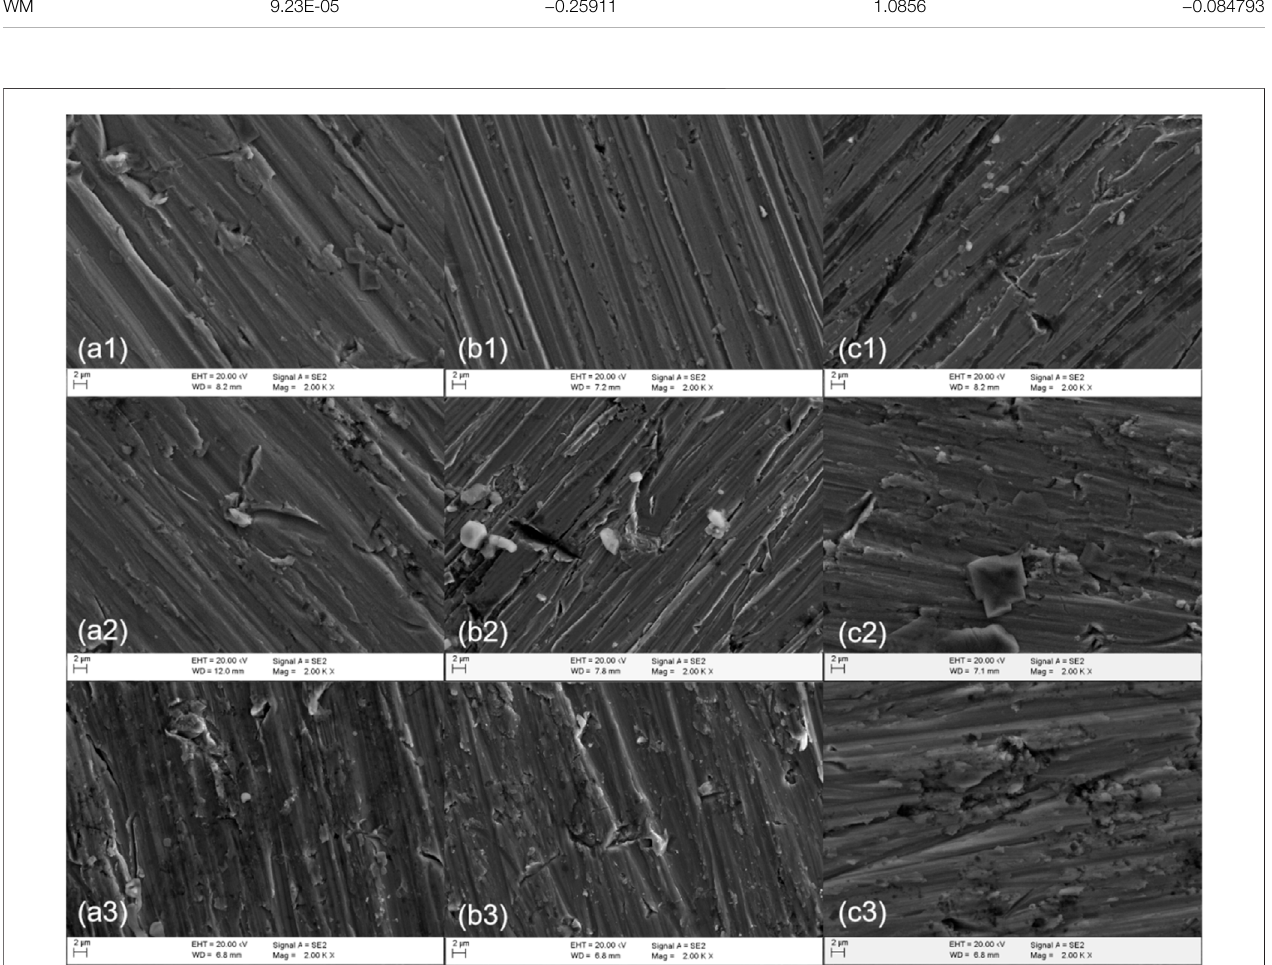
FIGURE 12 | SEM of titanium alloy welded joint after soaking in seawater at different temperatures for 12 h (A) BM (B) HAZ (C) WM (1) 25 ° C (2) 35 ° C (3) 45 ° C.